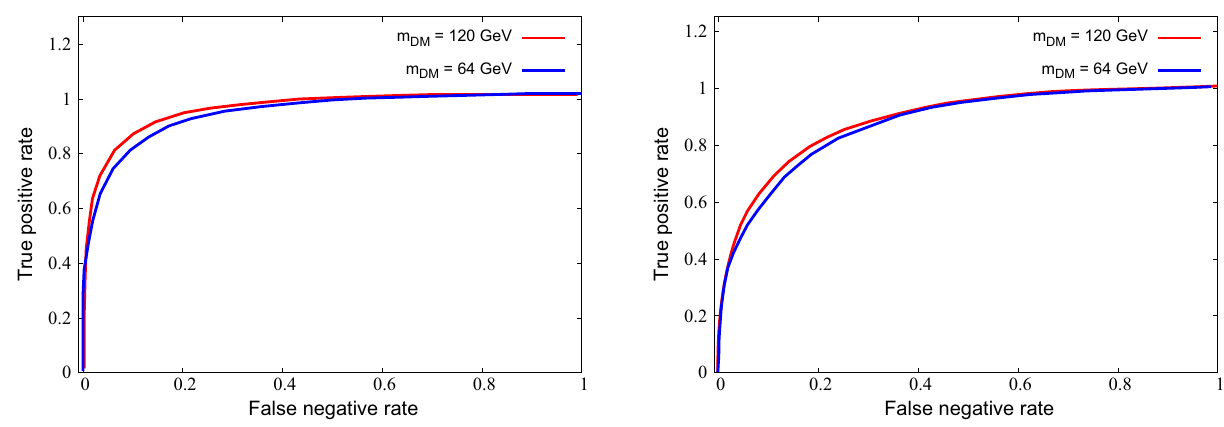
Fig. 18 Normalized distributions of / E T significance (left) and H T (right) for signal and backgrounds